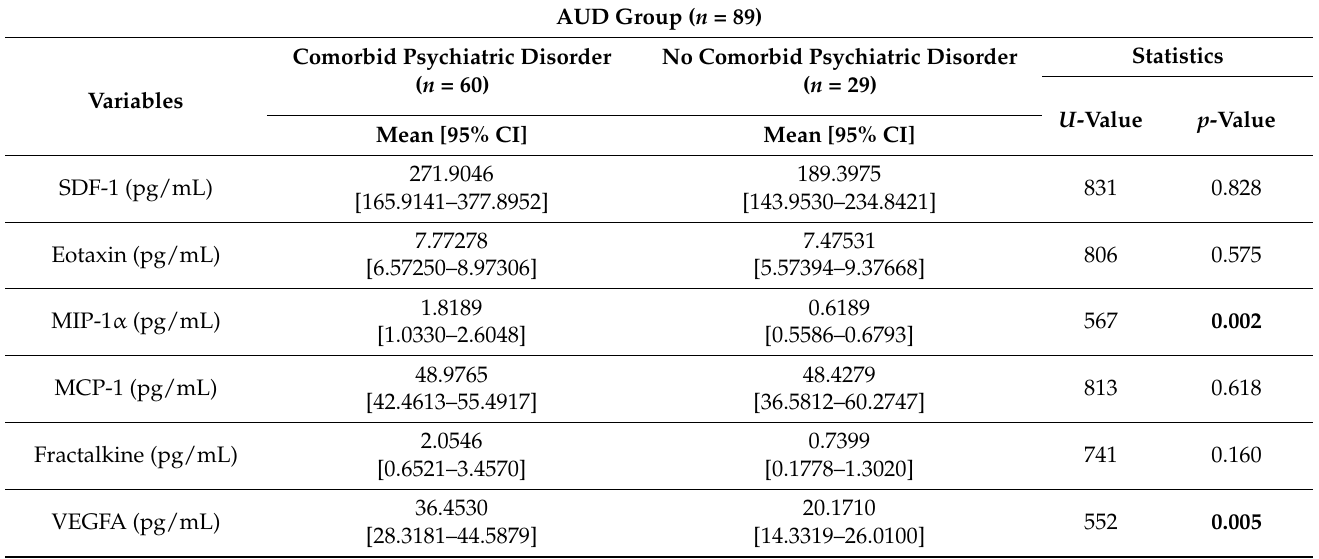
Table 4. Plasma concentrations of chemokines and VEGFA grouped according to comorbid psychiatric disorder. Bold values are statistically significant for p <